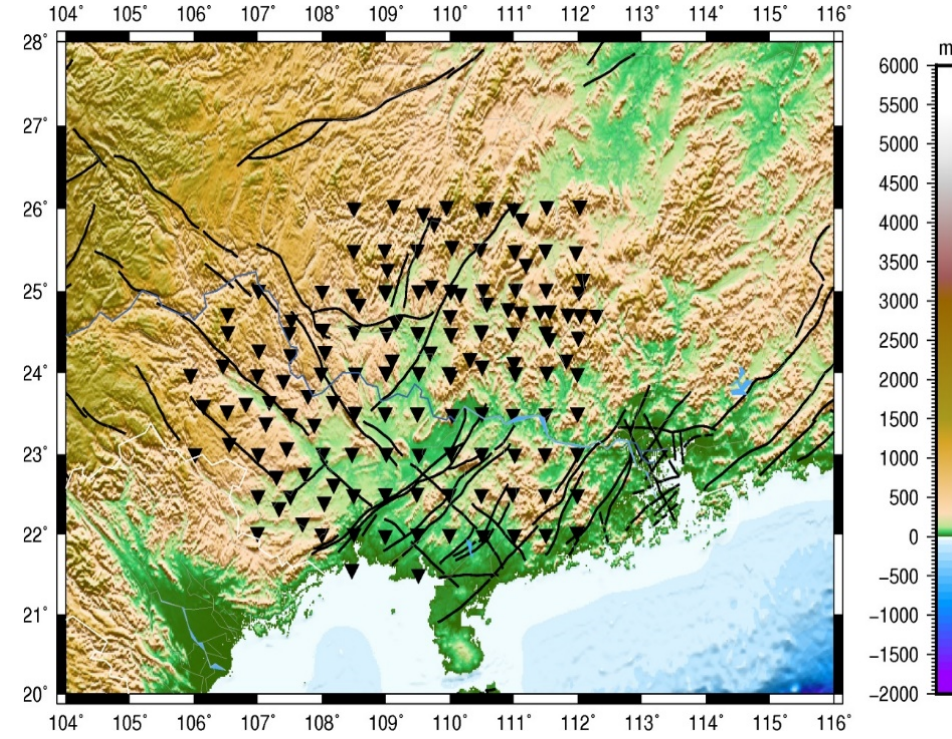
Figure 5. Map of stations.